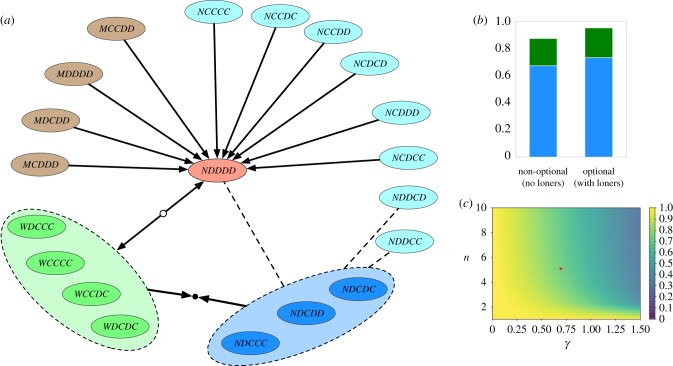
Evolutionary dynamics for the 20 consistent conditional strategies. (a) Evolutionary dynamics between pairs of strategies. We only depict invasions that are prevalent in the dynamics under strong selection. Given sufficient time, stable coexistences between two kinds of players emerge: those that support pro-social punishment and those not supporting any institution, but cooperating in the presence of pro-social punishment. For simplicity, the diagram focuses on a non-optional game: adding the loner strategy creates a fast path from defection, via loners, into either side of the stable mixture. (b) There are 12 different stable coexistences with similar abundance based on the four strategies supporting pro-social punishment and the three opportunistic strategies that cooperate in the presence, but defect in the absence, of coordinated pro-social punishment. We group these strategies in the cases of non-optional and optional public goods games. Averages taken as described in figure 2. (c) The probability that a pro-social pool is implemented in the coexistence decreases with increasing costs γ and increasing group size n. The dot indicates our default set of parameters (see main text or figure 2). (Online version in colour.)